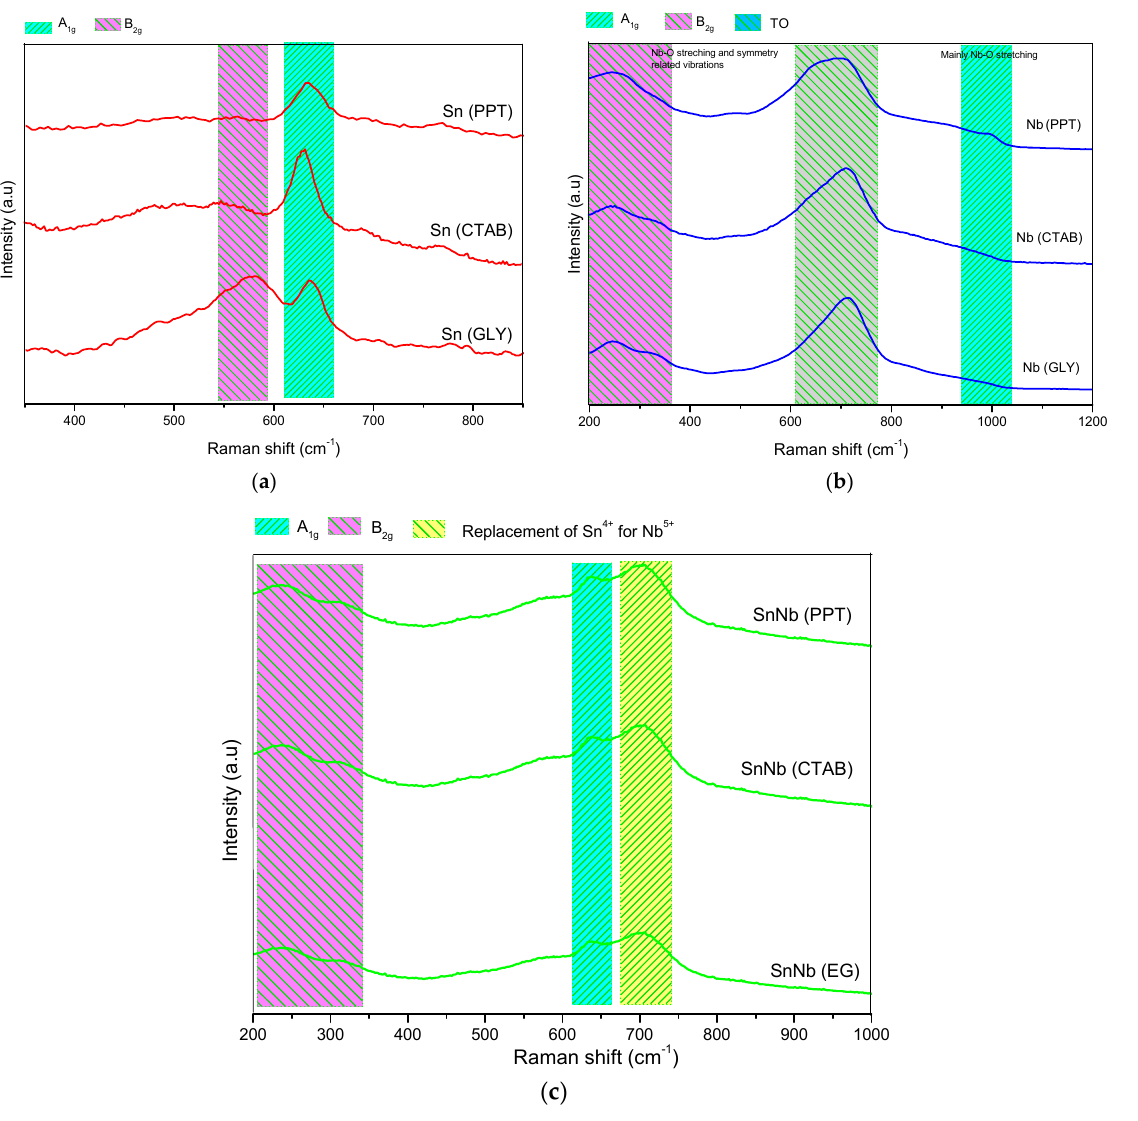
Figure 3. Raman spectra of the catalysts: ( a ) Sn(PPT), Sn(CTAB) and Sn(GLY); ( b ) Nb(PPT), Nb(CTAB) and Nb(GLY); and ( c ) SnNb(PPT), SnNb(CTAB) and SnNb(GLY).